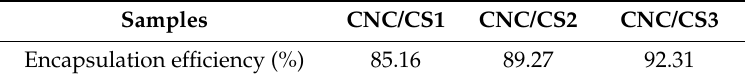
Table 3. Encapsulation efficiency of theophylline for different hydrogels.